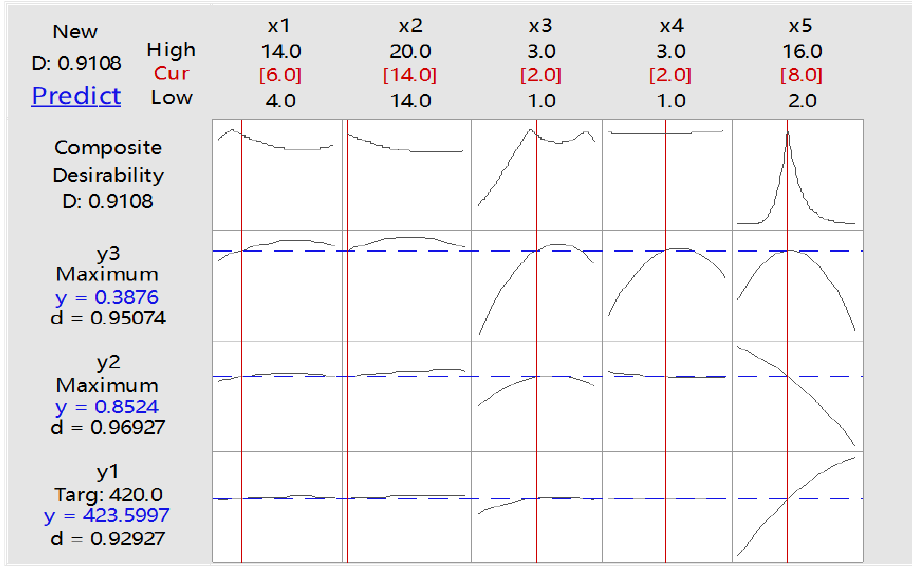
Figure 5. Multi-response optimization results of the second delivery period.